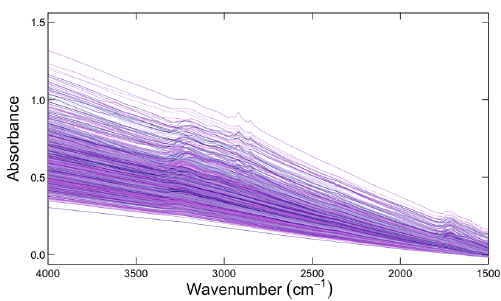
Figure 1. 794 FT-IR atmospheric aerosol spectra collected on PTFE filter. Each spectrum is